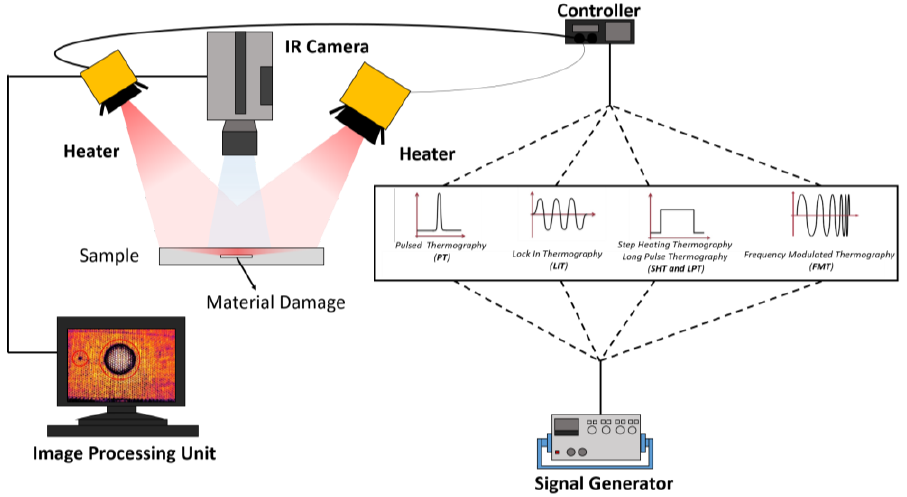
Figure 2. Schematic diagram of optically stimulated thermography (OST). Table 3. Summary of signal processing techniques used for OST.